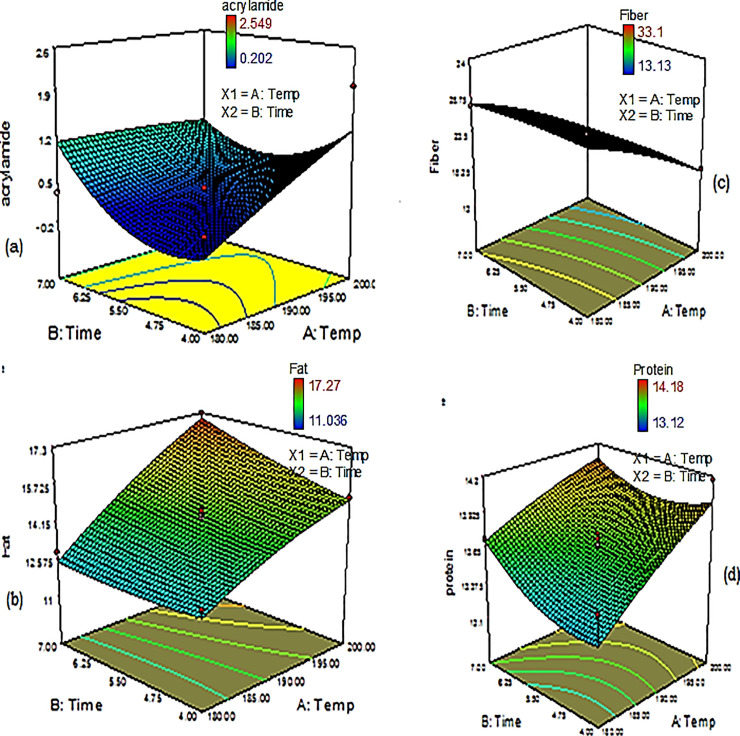
3D plot of a) acrylamide b) fat c) fiber d) protein content of optimized roasted Sidama coffee.